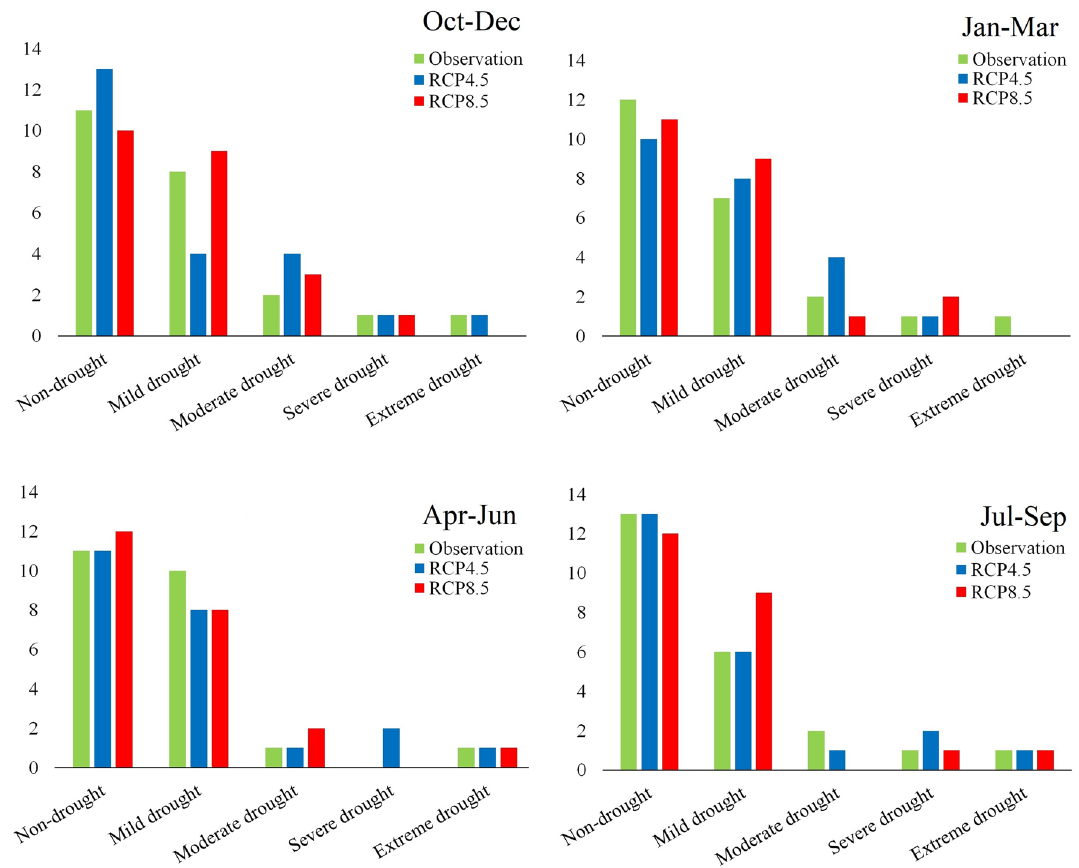
Fig. 20 3-Month Streamflow Drought Index (SDI) in the baseline and future periods under the scenarios (RCP4.5 and